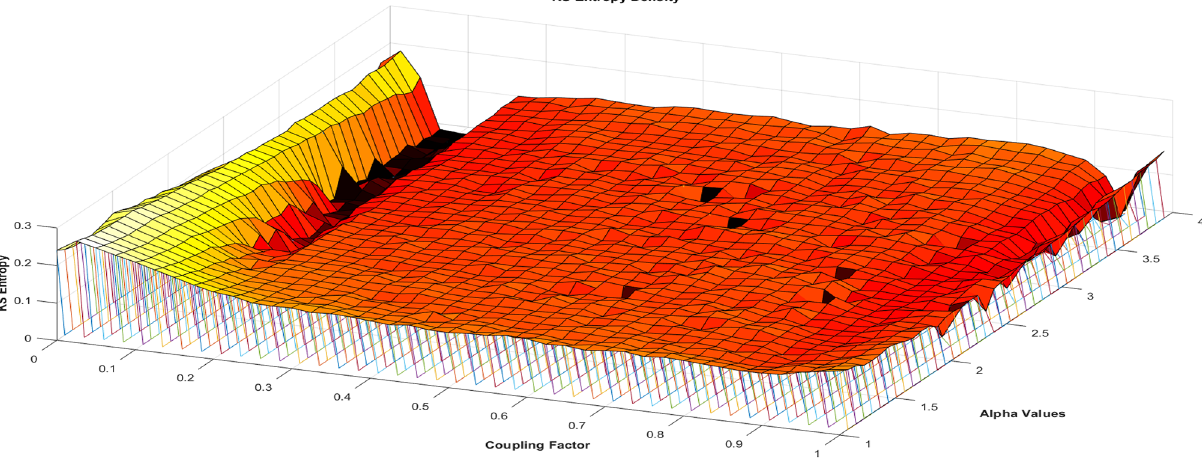
Fig. 8 Shows KS entropy density plot for CML system with GSM and adaptive 𝛽 for the set parameters ( 1 ≤ 𝛼 ≥ 4 , 0 ≤ 𝜖 ≥ 1 , 𝛽 = adaptive, N = 100 and 𝛾 =